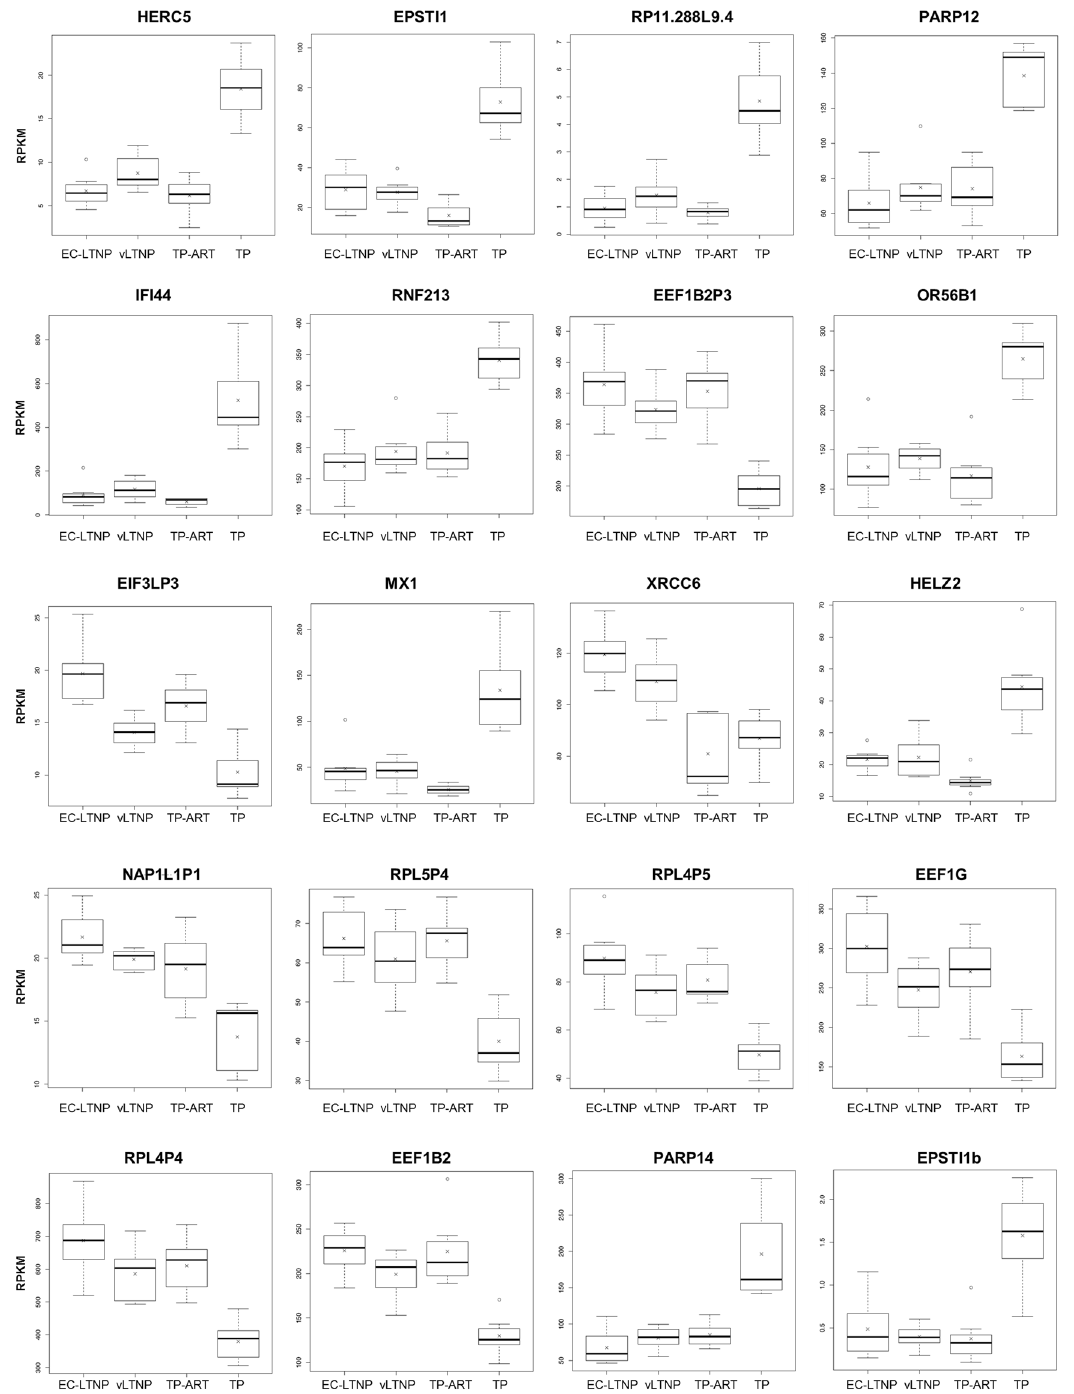
Figure 2. Best predictor genes of disease progression according to the hierarchical Bayesian classification model. The boxplots were generated in R and show the first and third quartile values for the RPKM distribution (upper and lower limits of the box), the median (the line splitting the box into two parts), the highest and lowest values (lines connected to the box through dashed lines), outlier values (open circles) and the mean value (crosses) for each